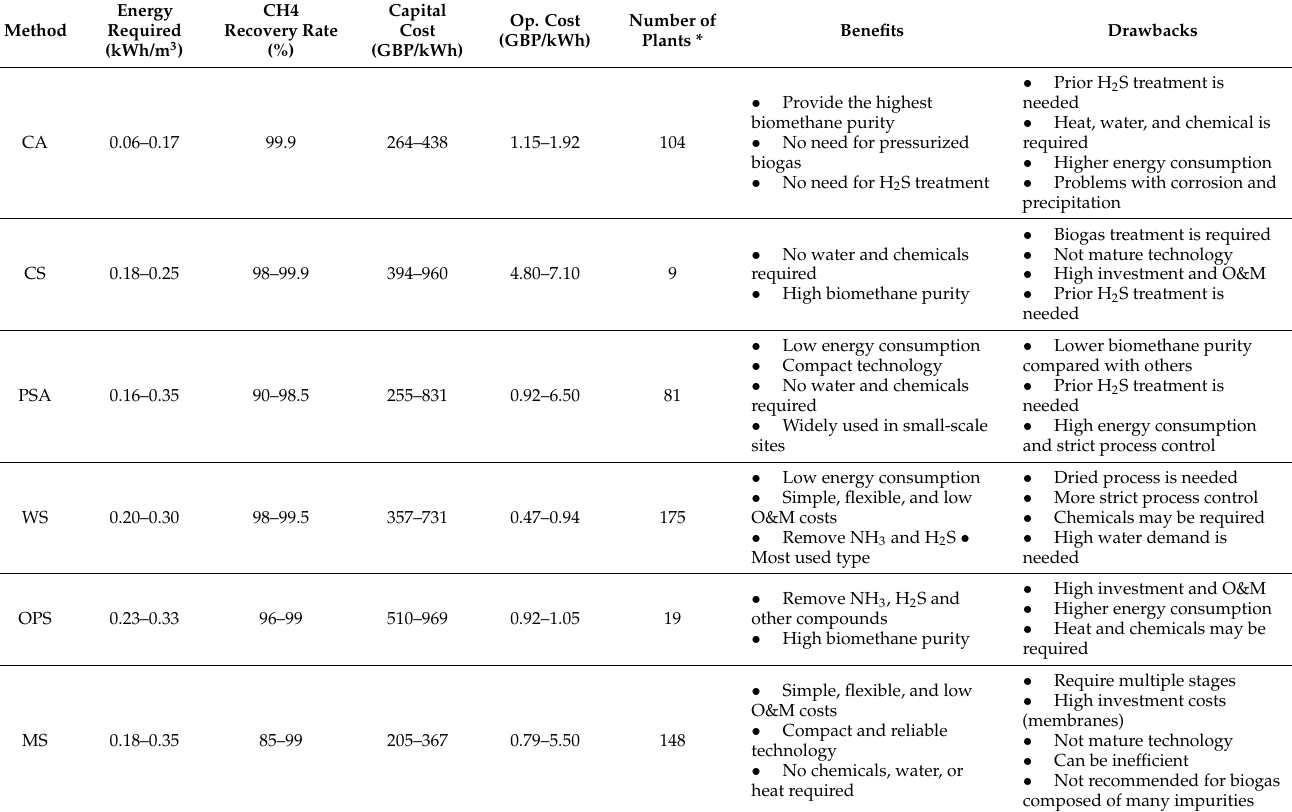
Table 8. Biogas upgrading technologies’